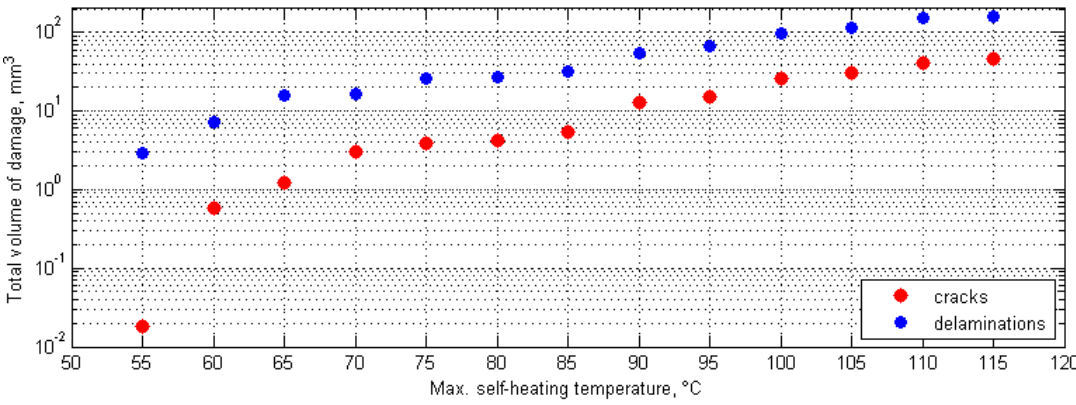
Figure 17. Total volume of damage for various self-heating temperature values.